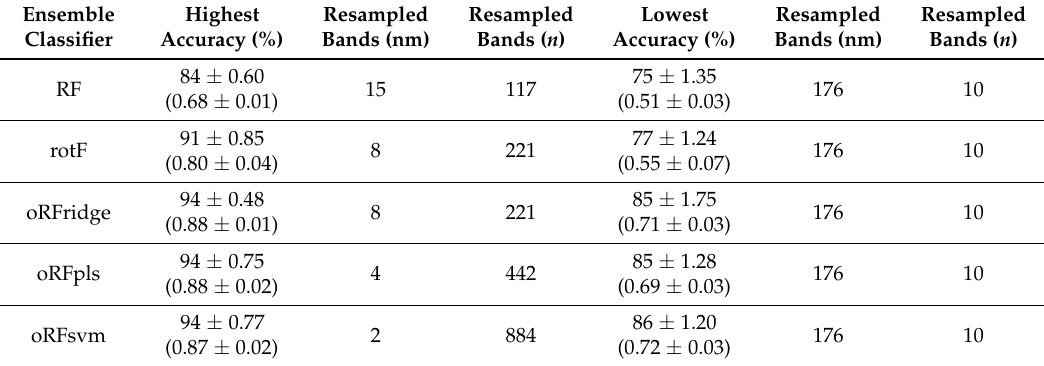
Table 1. Spectral resampled wavelengths and the associated classification results using the five ensemble classifiers (RF = random forest; rotF = rotation forest; oRFridge = oblique random forest using ridge regression as splitting model; oRFpls = oblique random forest using PLS as splitting model; oRFsvm = oblique random forest using SVM as splitting model). KHAT values are indicated in